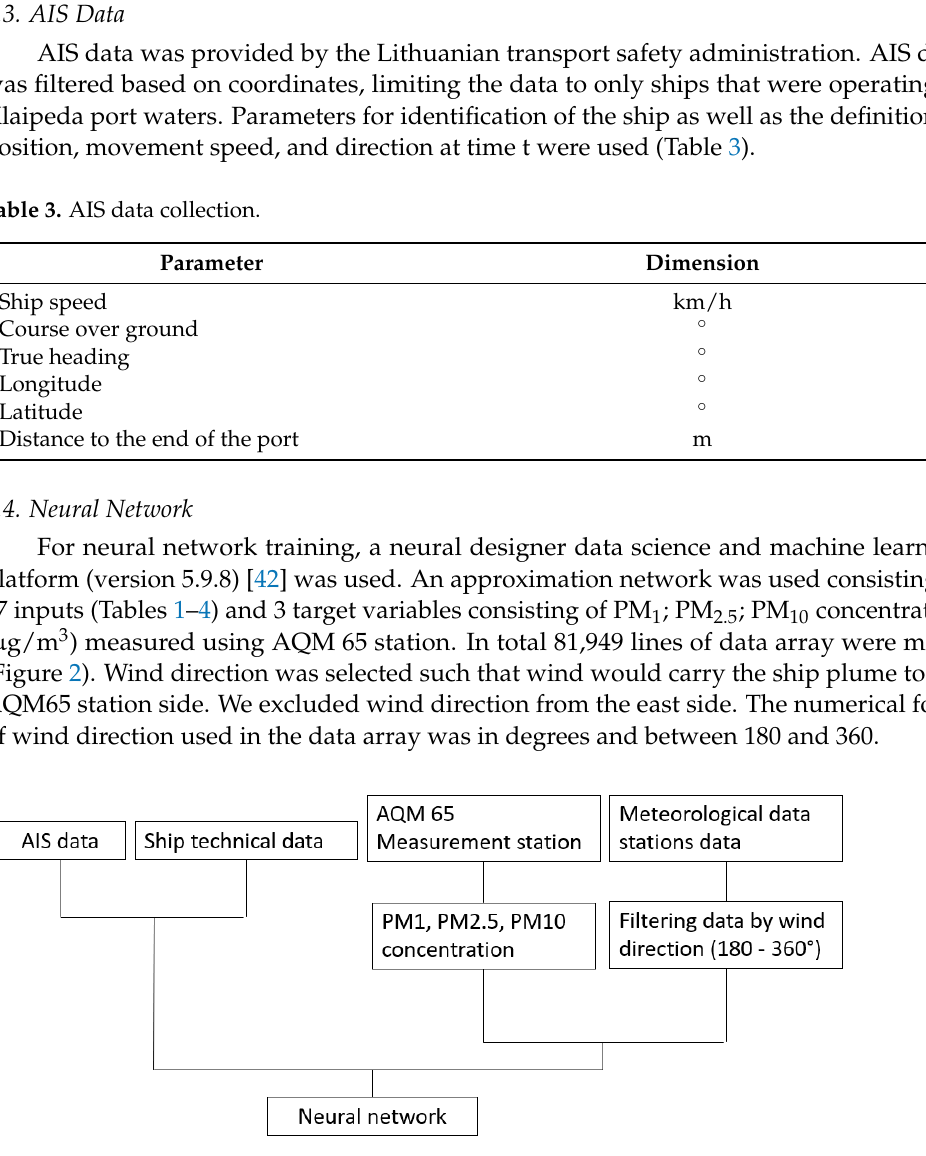
Figure 2. Algorithm for neural network preparation.